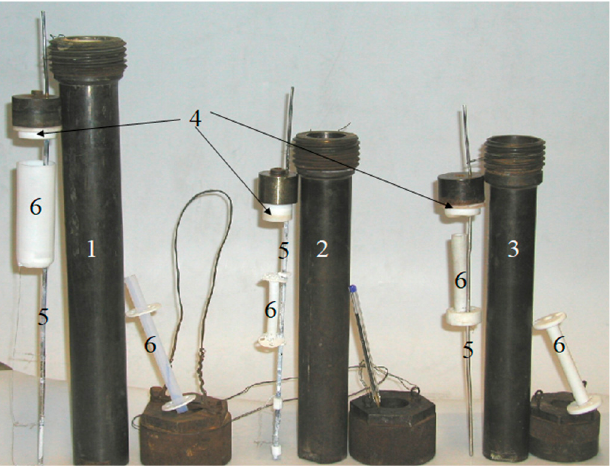
Figure 10. (1,2) Ta ‐ and (3) Pt ‐ lined steel autoclaves with PTFE cover; (4) autoclaves equipped with an (5) internal temperature control probe and (6) PTFE nutrient basket. Pen for scale. (5) internal temperature control probe and (6) PTFE nutrient basket. Pen for